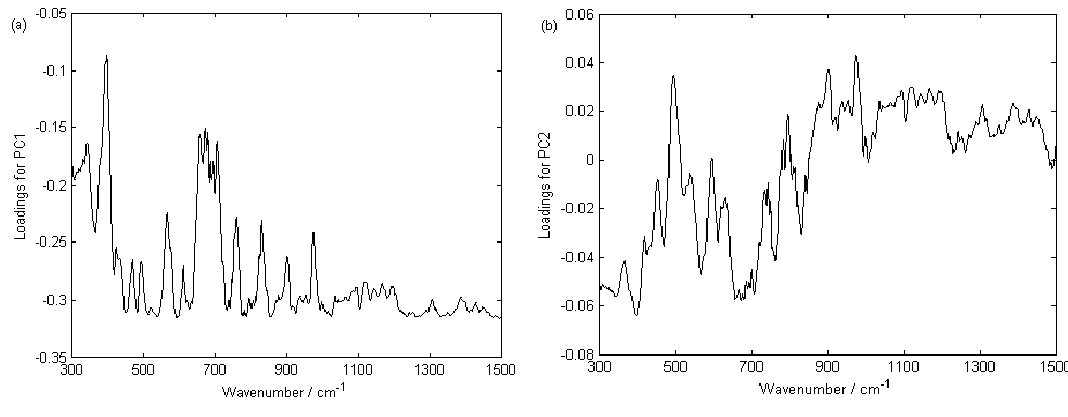
Figure 6. The loading plots for PC1 ( a ) and PC2 ( b ).